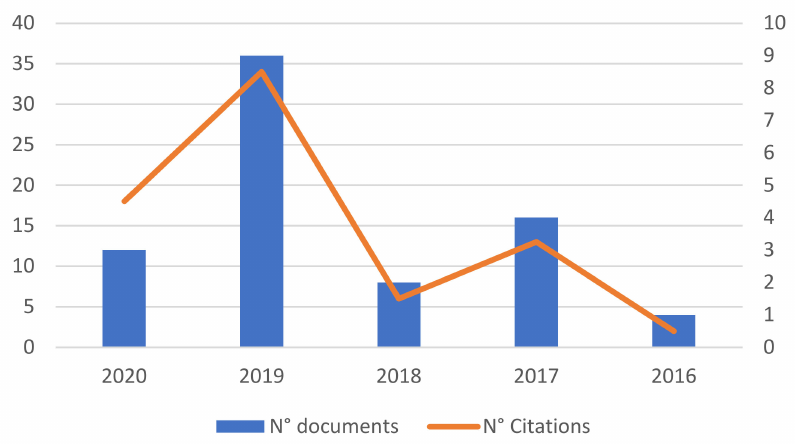
Figure 3. Publication volume and citations in the literature (source: